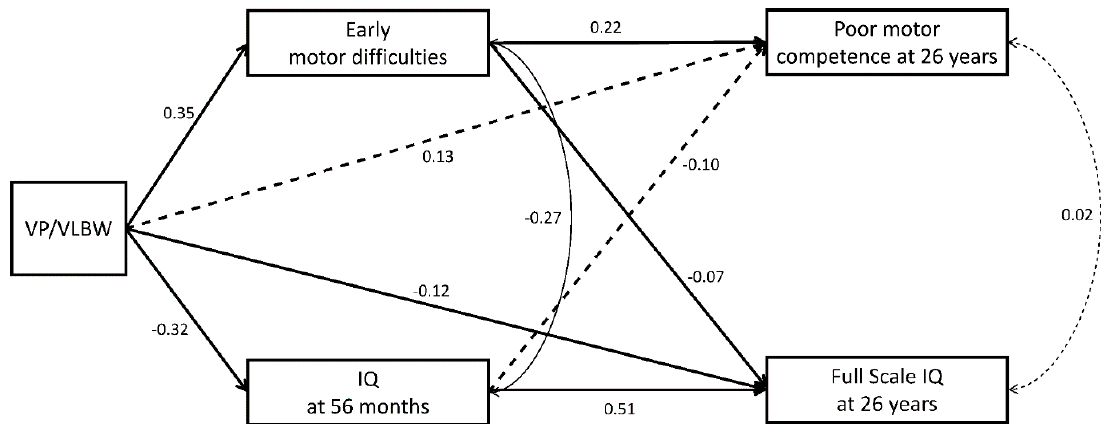
Figure 2. Structural equation model showing direct and indirect e ff ects of VP / VLBW and early motor trajectories (di ffi culties) on motor competence and IQ at 26 years (Model 1). Bold lines represent